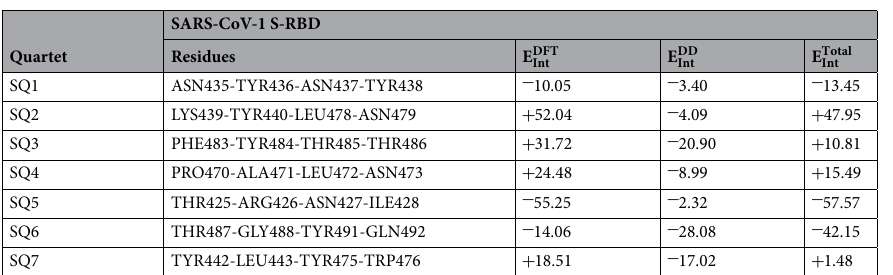
a b with neighboring hACE2